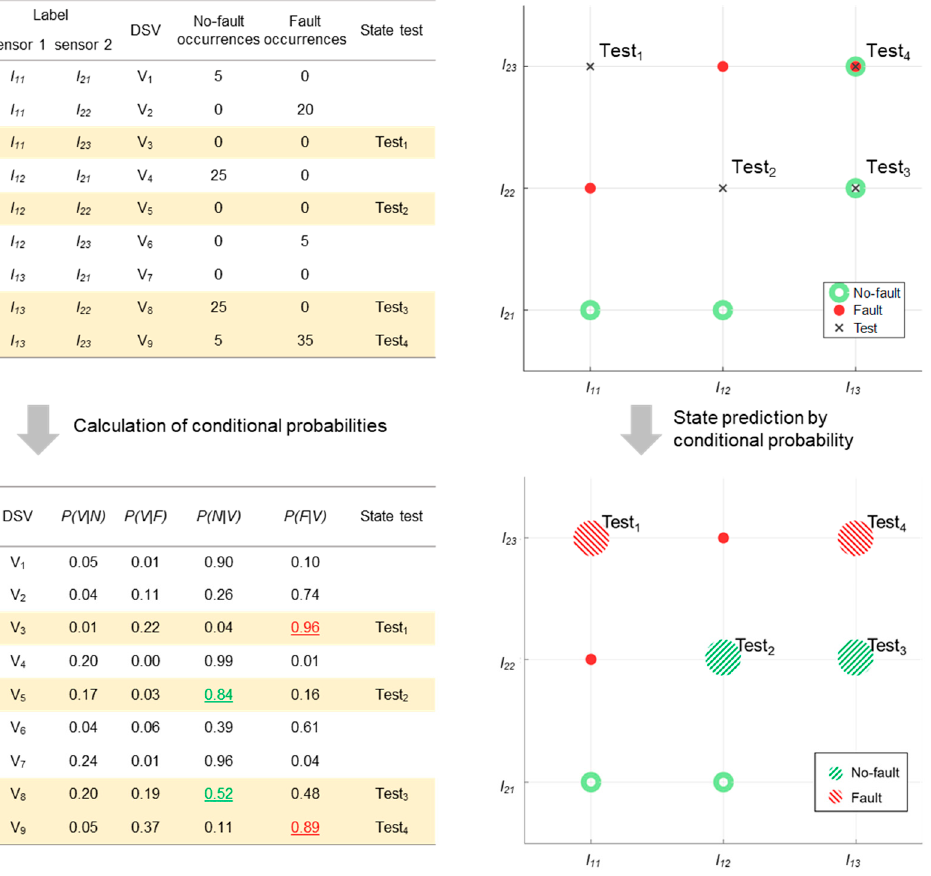
Figure 3. State prediction by conditional probability.